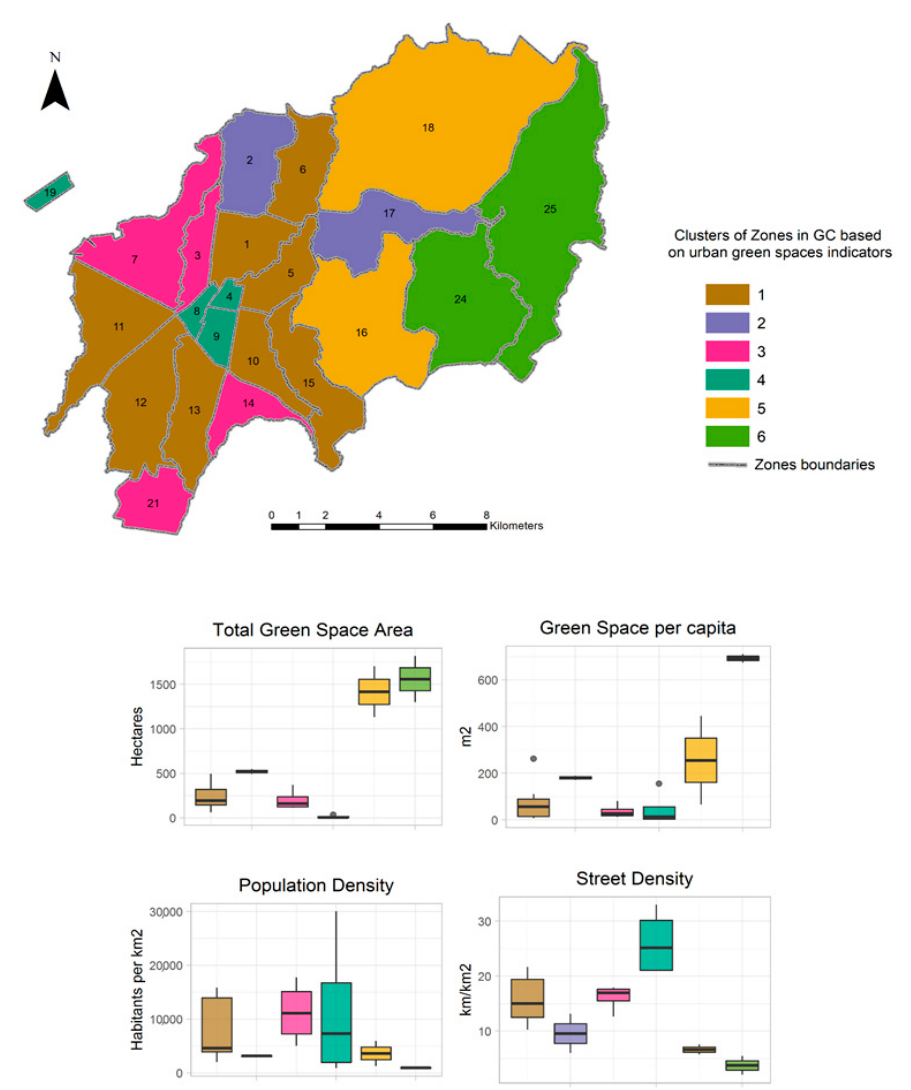
Figure 7. The use of indicators based on green spaces and their spatial characteristics measured by selected metrics allow identification of six ensembles of zones. Upper is the spatial representation of the clusters. Lower graphs show quantitative data of ensembles based on four indicators used for the clustering are shown. (The rest are in Figure S6).